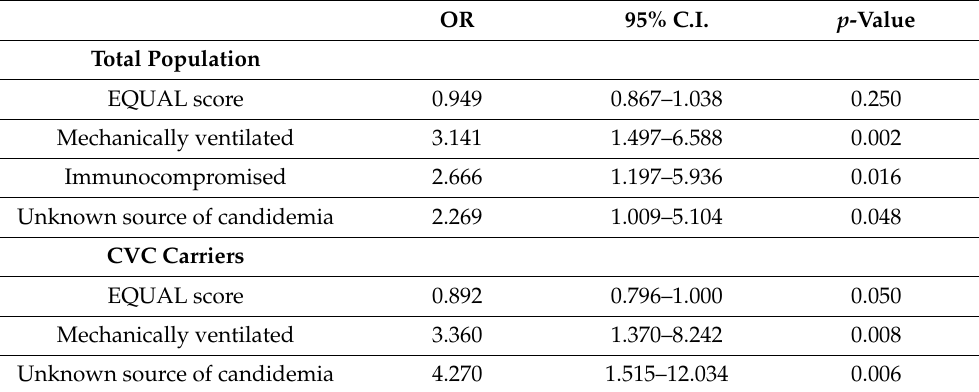
Table 4. Multivariable logistic regression of factors associated with the 30-day case-fatality rate after diagnosis of candidemia.